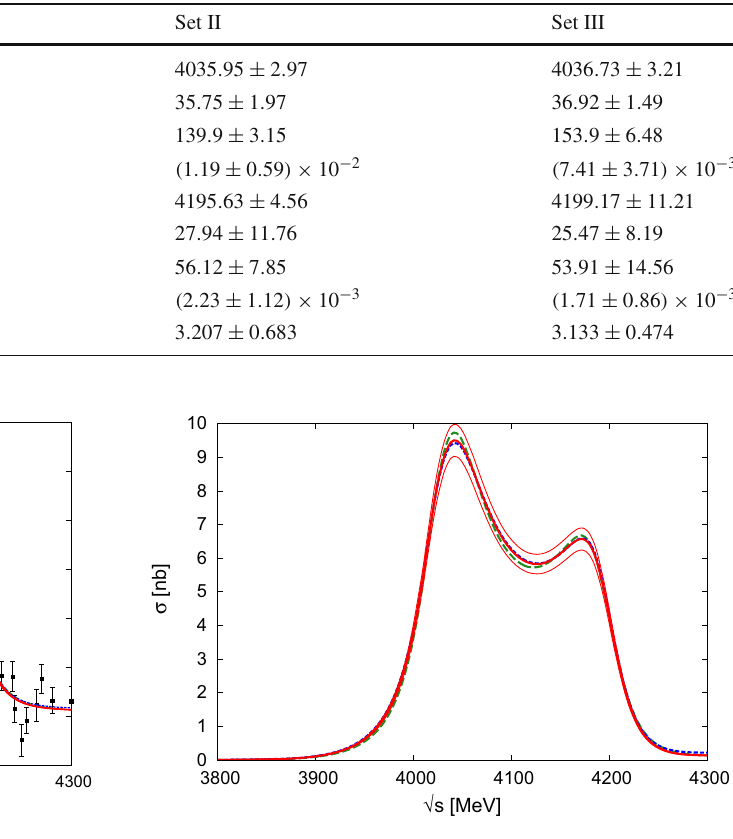
Fig. 6 The total hadronic cross section of σ( e + e − → hadrons ) without background. The solid red line corresponds the parameters Set I, dashed green line Set II and dotted blue line Set III. The most extreme thinlinesprovidethebandofuncertaintyofthefitevaluatedasexplained in the tex